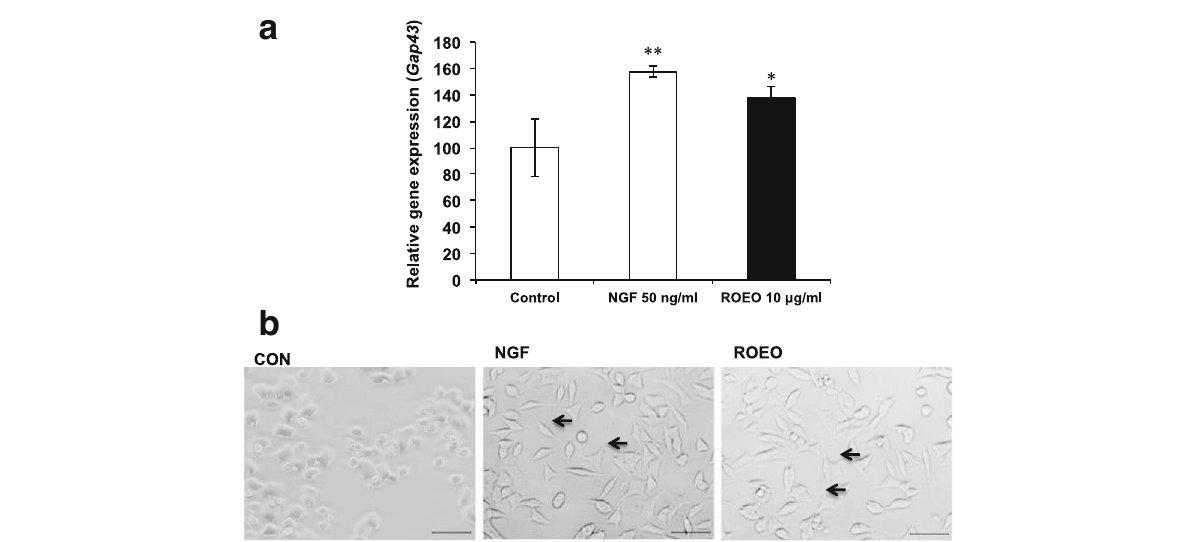
Fig. 3 Effect of Rosmarinus officinalis essential oil (ROEO) on the PC12 cells neuronal outgrowth elongation.PC12 cells were seeded onto 96-well plates at a density of 1×10 5 cells/ml. After overnight incubation, PC12 cells were treated with 50 ng/ml of nerve growth factor (NGF) or 10 μ g/ml of ROEO for 48 h. Control cells were incubated for 48 h without NGF or ROEO treatment. a Expression of growth associated protein 43 ( Gap43 ) mRNA quantified using real-time PCR and normalized to Gapdh mRNA expression. Data represent the mean of three independent trials ±.SD * P ≤ 0.05, ** P ≤ 0.01 vs. control. b Morphology of PC12 cells treated without (Control) or with 50 ng/ml NGF (NGF) or 10 μ g/ml of ROEO (ROEO). The photographs were taken 48 h after sample treatment and arrows point to cells with dendritic morphology. Photographs of the cells at 200× magnification were taken using a phase contrast microscope equipped with DFC 290HD camera (Leica Microsystem). The scale-bar represents 50 μ m